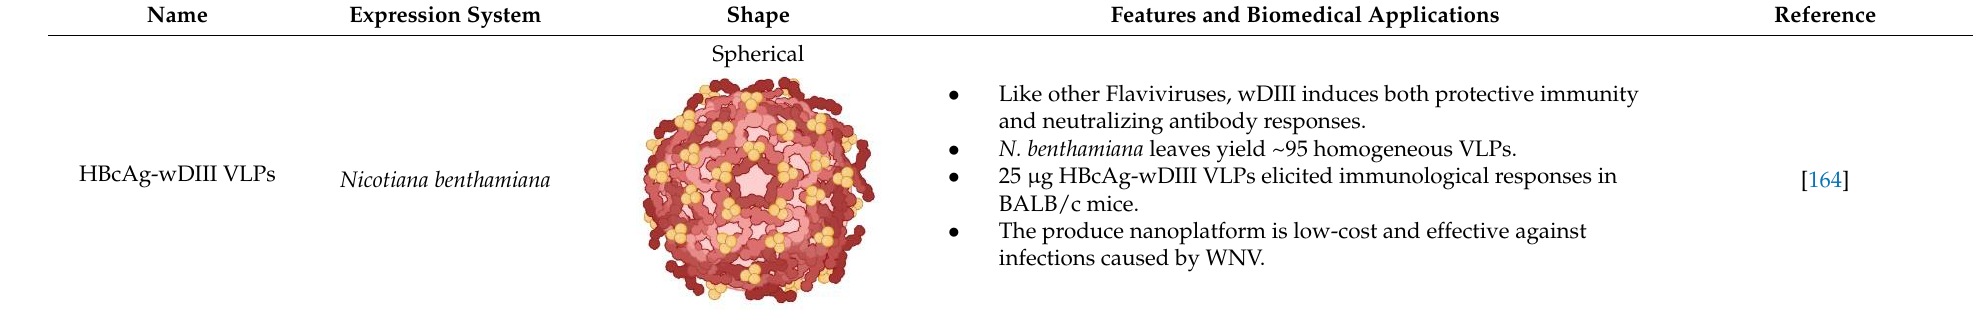
Table 2. VLPs with biomedical applications: expression systems, structure, and